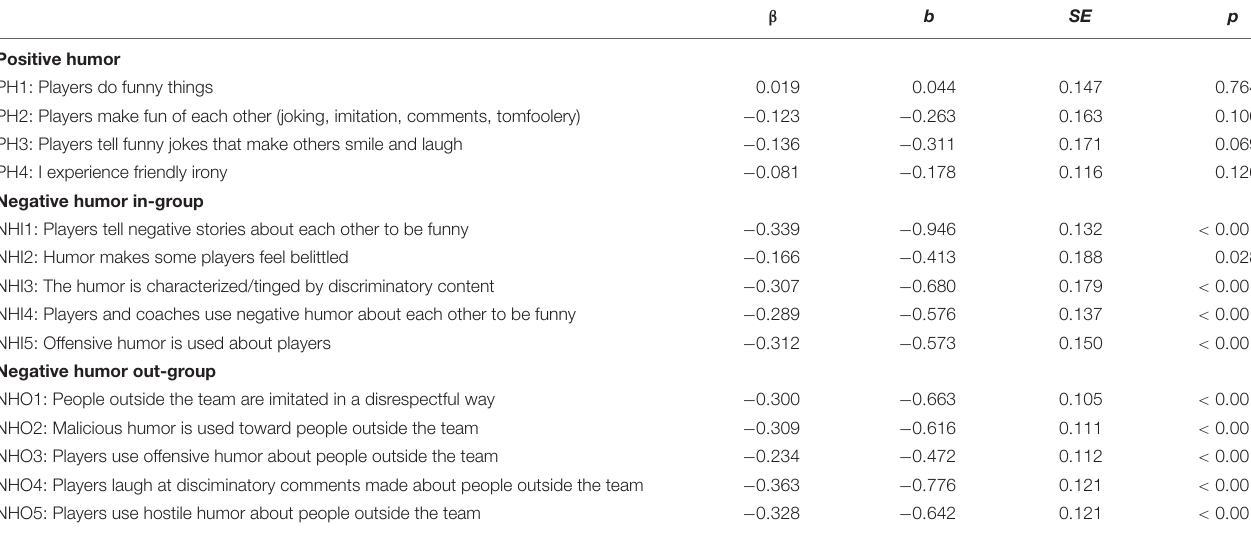
TABLE 8 | Effect of sex on the item responses in the saturated MIMIC model (sample 2).